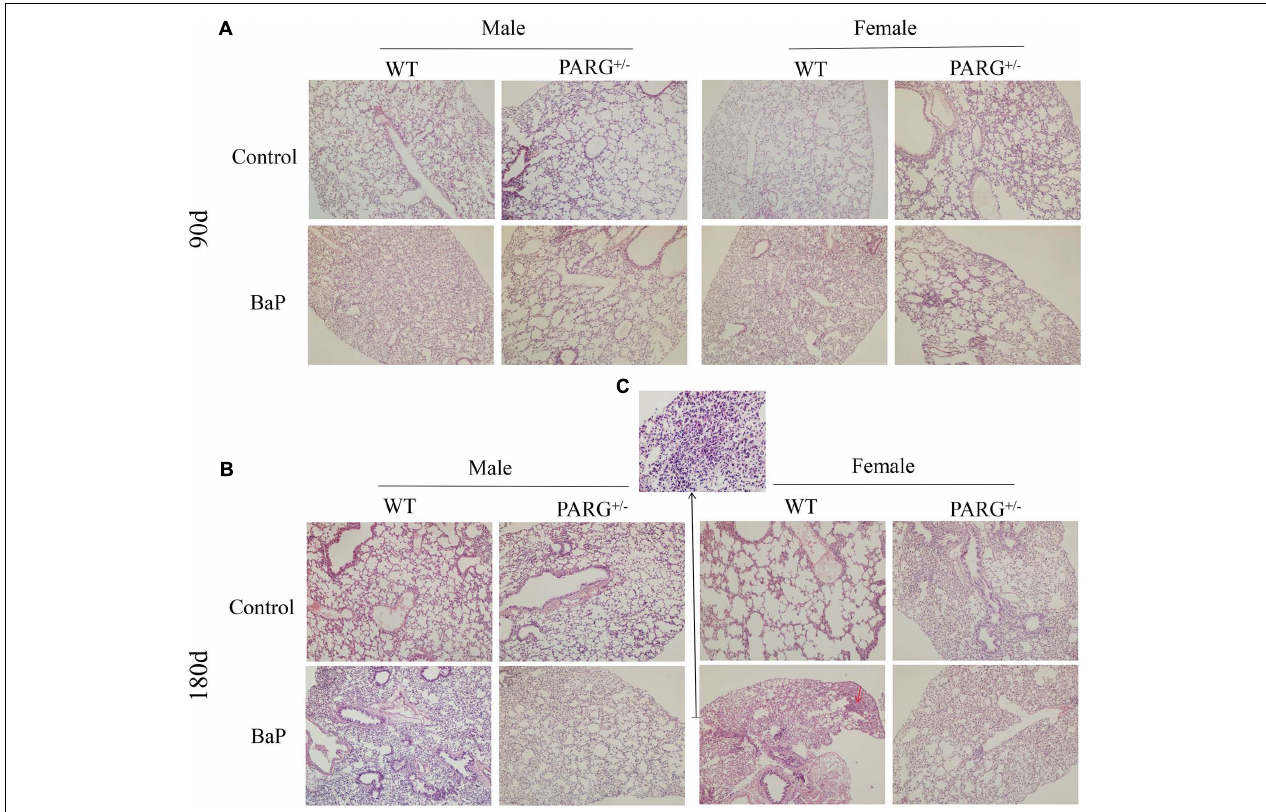
FIGURE 2 | PARG + / − mice are protected from pathological changes in lung tissues induced by BaP inhalation exposure. Pathological changes in lung tissues of WT and PARG + / − mice after benzo(a)pyrene inhalation exposure (A) 90-day exposure ( × 100). (B) 180-day exposure to BaP ( × 100). The red arrows show abnormally increased numbers of cells. (C) The magnification of the place pointed by the red arrow in B , pathological signs of tumorigenesis ( × 200). Results are representative of 3 mice from each group.